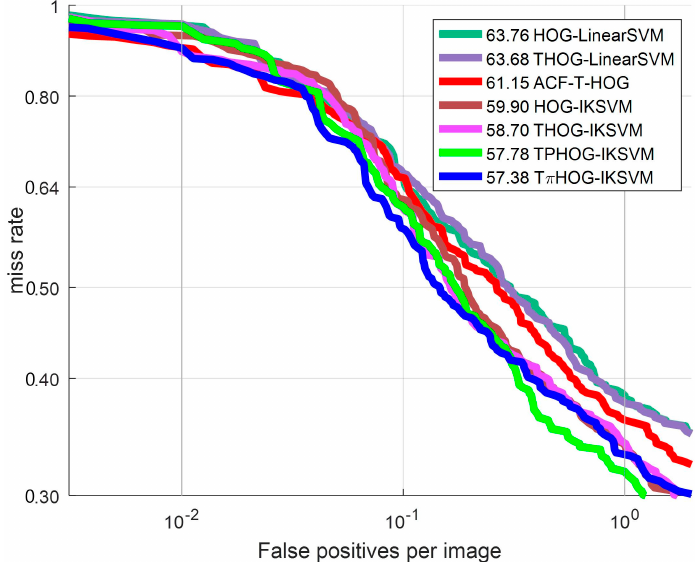
Figure 17. ROC curve: Comparison of feature.